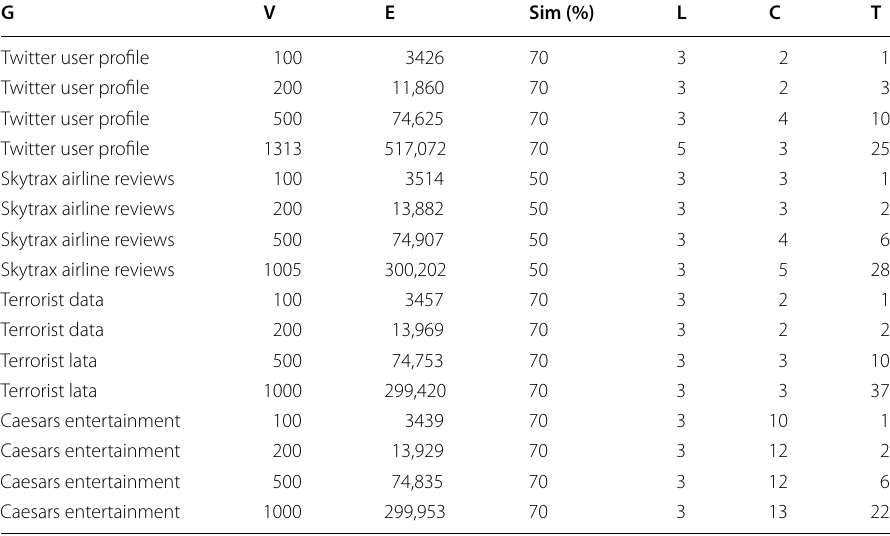
Table 9 Experimental results on small graphs